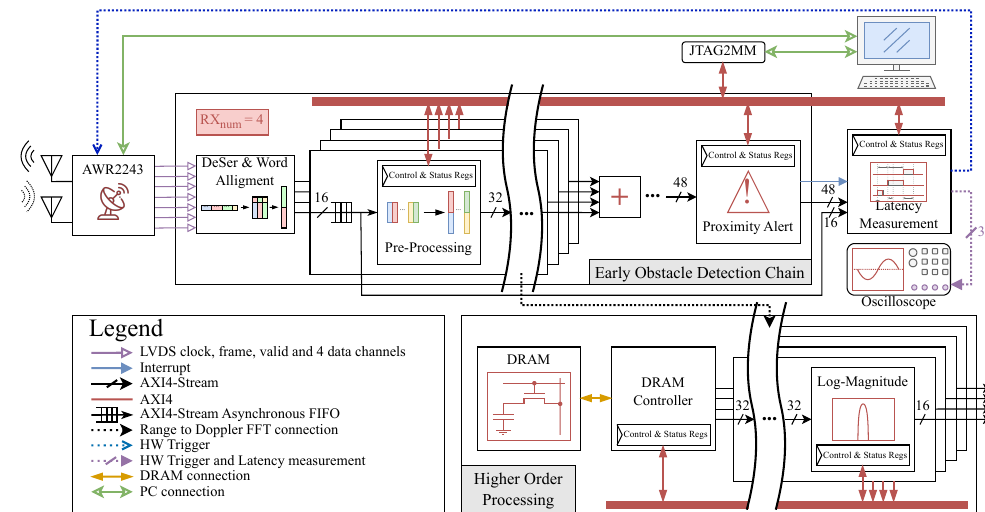
Figure 14. Block diagram of the experiment setup for the proposed radar signal processing architec- ture for early detection of automotive obstacles. The latency measurement block controls when the AWR2243 radar front-end will start its processing and it is used to generate signals used for latency measurement. These signals are connected to the oscilloscope. PC is used to set the parameters of the AWR2243 and to write to the control registers of the early obstacle detection chain.